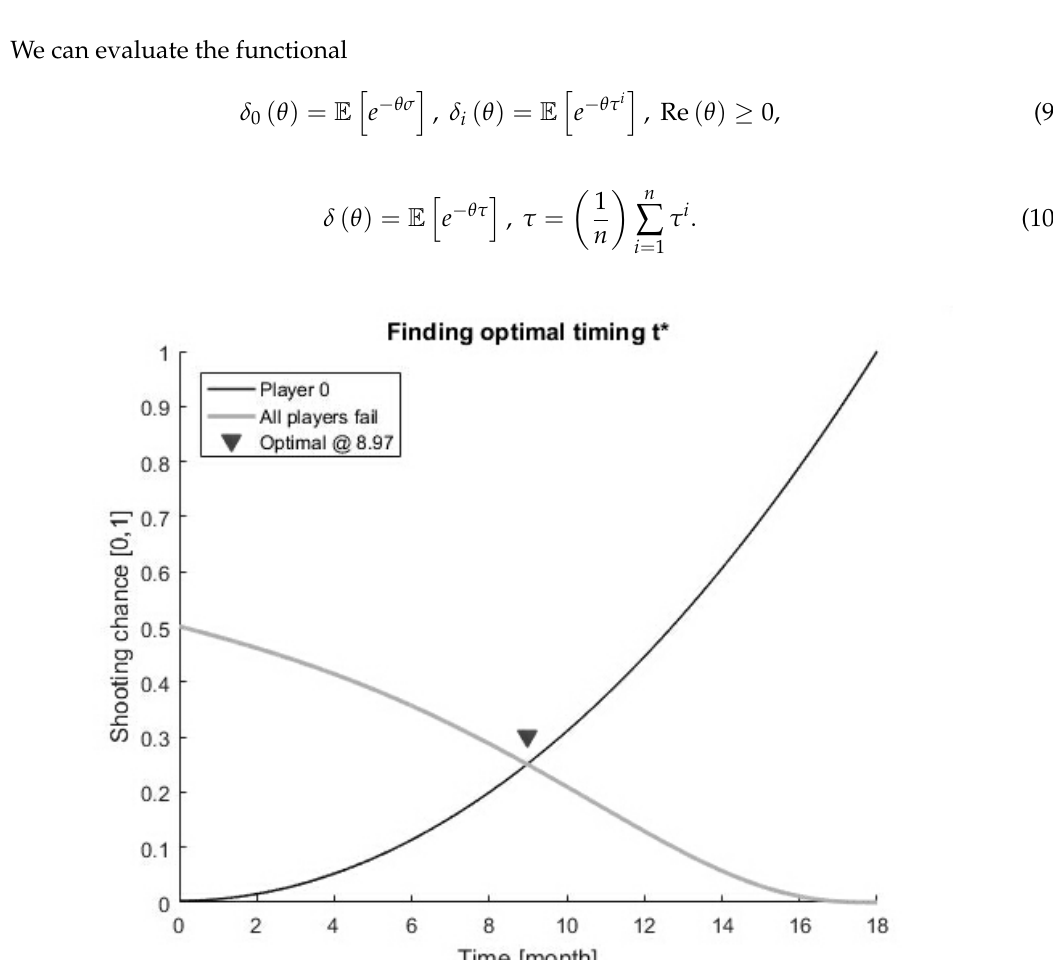
Figure 2. Best shooting moment t ∗